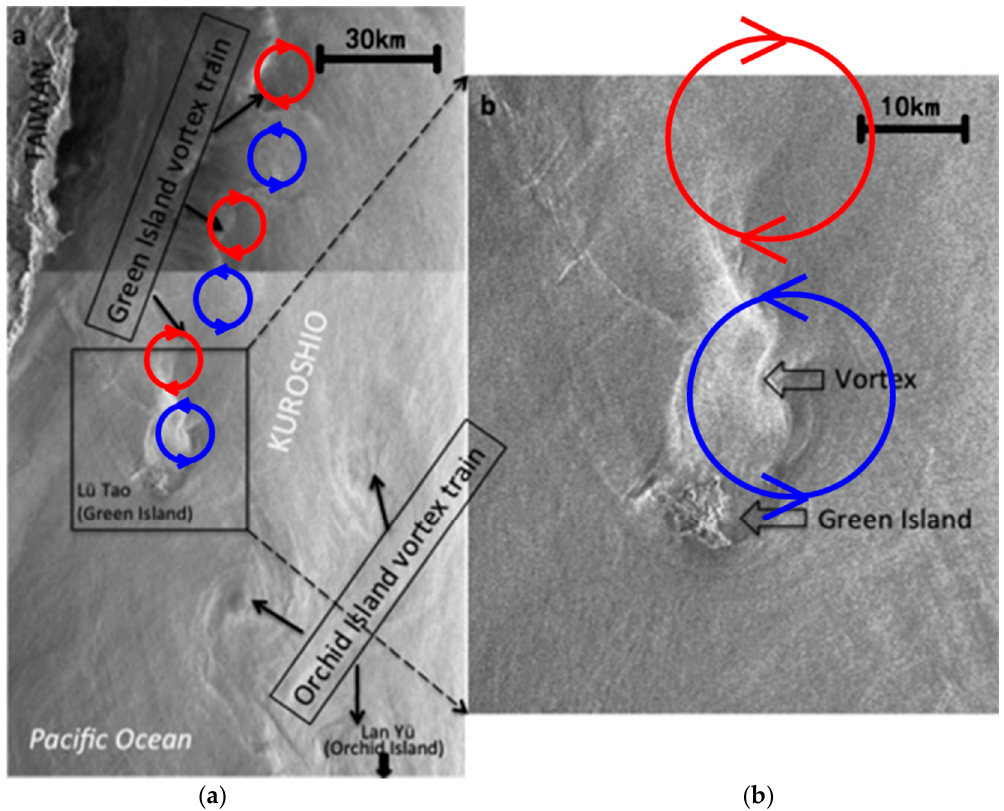
Figure 3. ( a ) A composite ERS-1 SAR image of island-induced ocean vortex trains of Lanyu Island and Green Island taken at 17:01 UT 25 September (lower) and 19:02 UT 2 October (top), 1996. ( b ) Zoomed Green Island and head of vortex train (modified from Figure 2 of Zheng and Zheng [43]). Blue circle represents for cyclonic (bright shading) vortexes and red circle represents for anticyclonic (dark shading) vortexes.